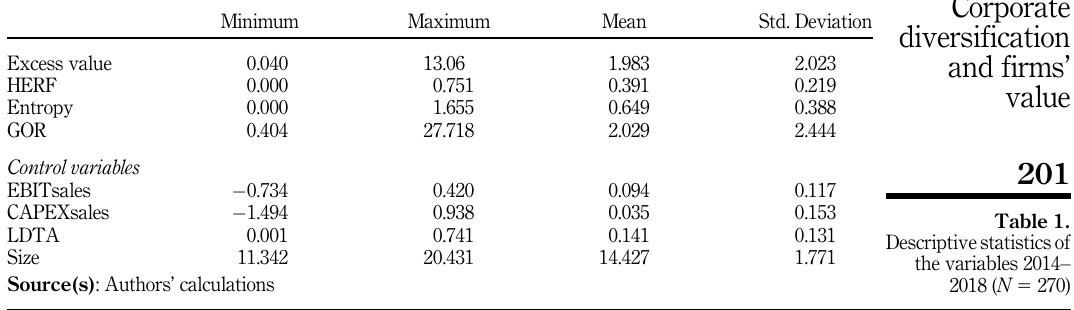
Table 1. Descriptivestatisticsof